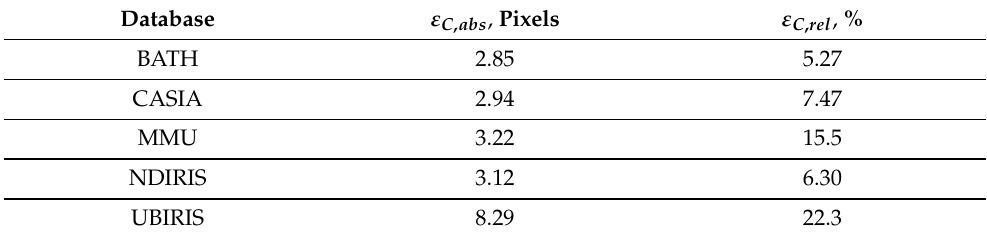
Table 1. Errors of eye center detection.